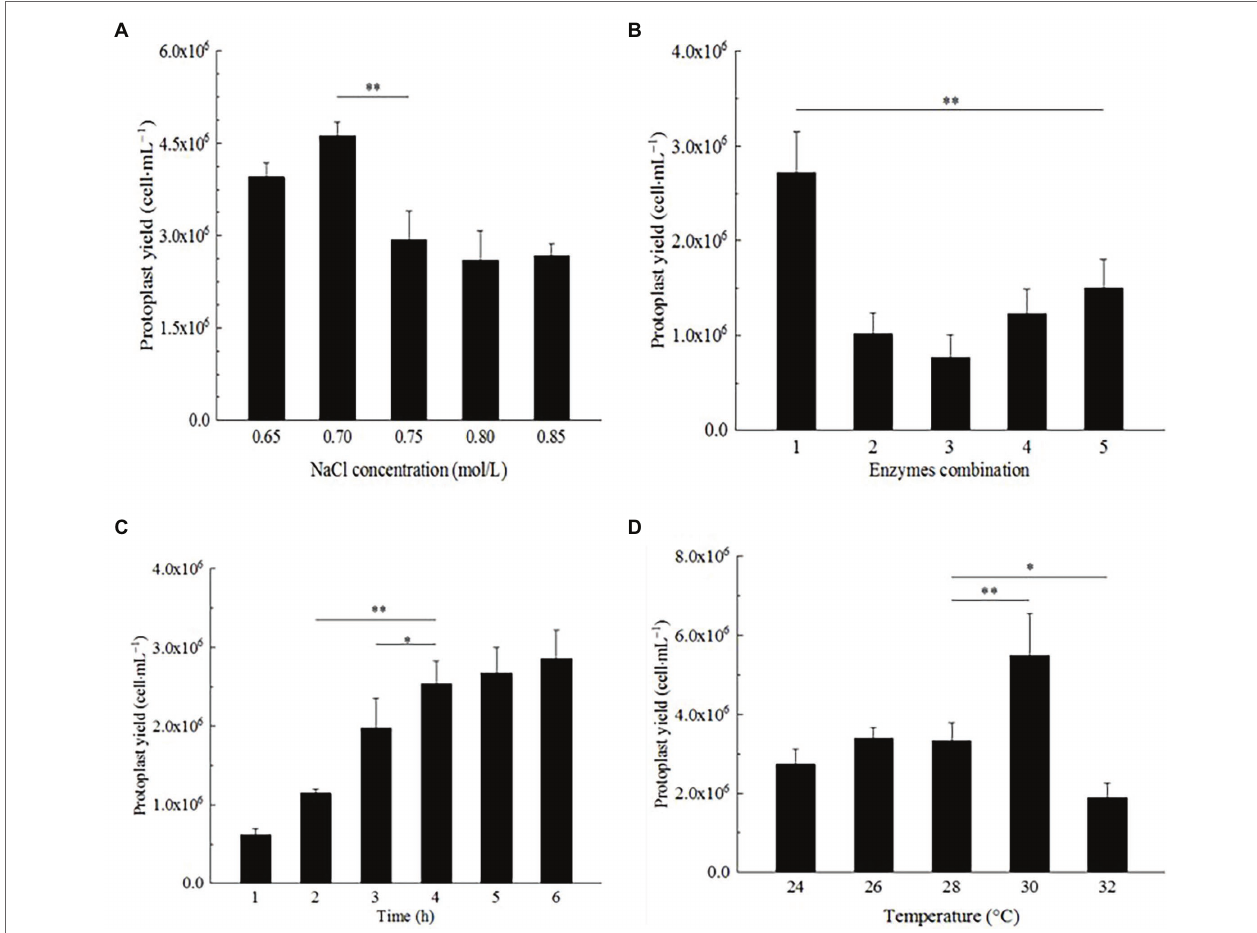
FIGURE 4 | Optimization of preparation conditions of strain D-1 protoplasts. (A) NaCl concentration. (B) Enzyme combination. (C) Enzymatic hydrolysis time. (D) Enzymatic hydrolysis temperature ( ** p < 0.01; * p <